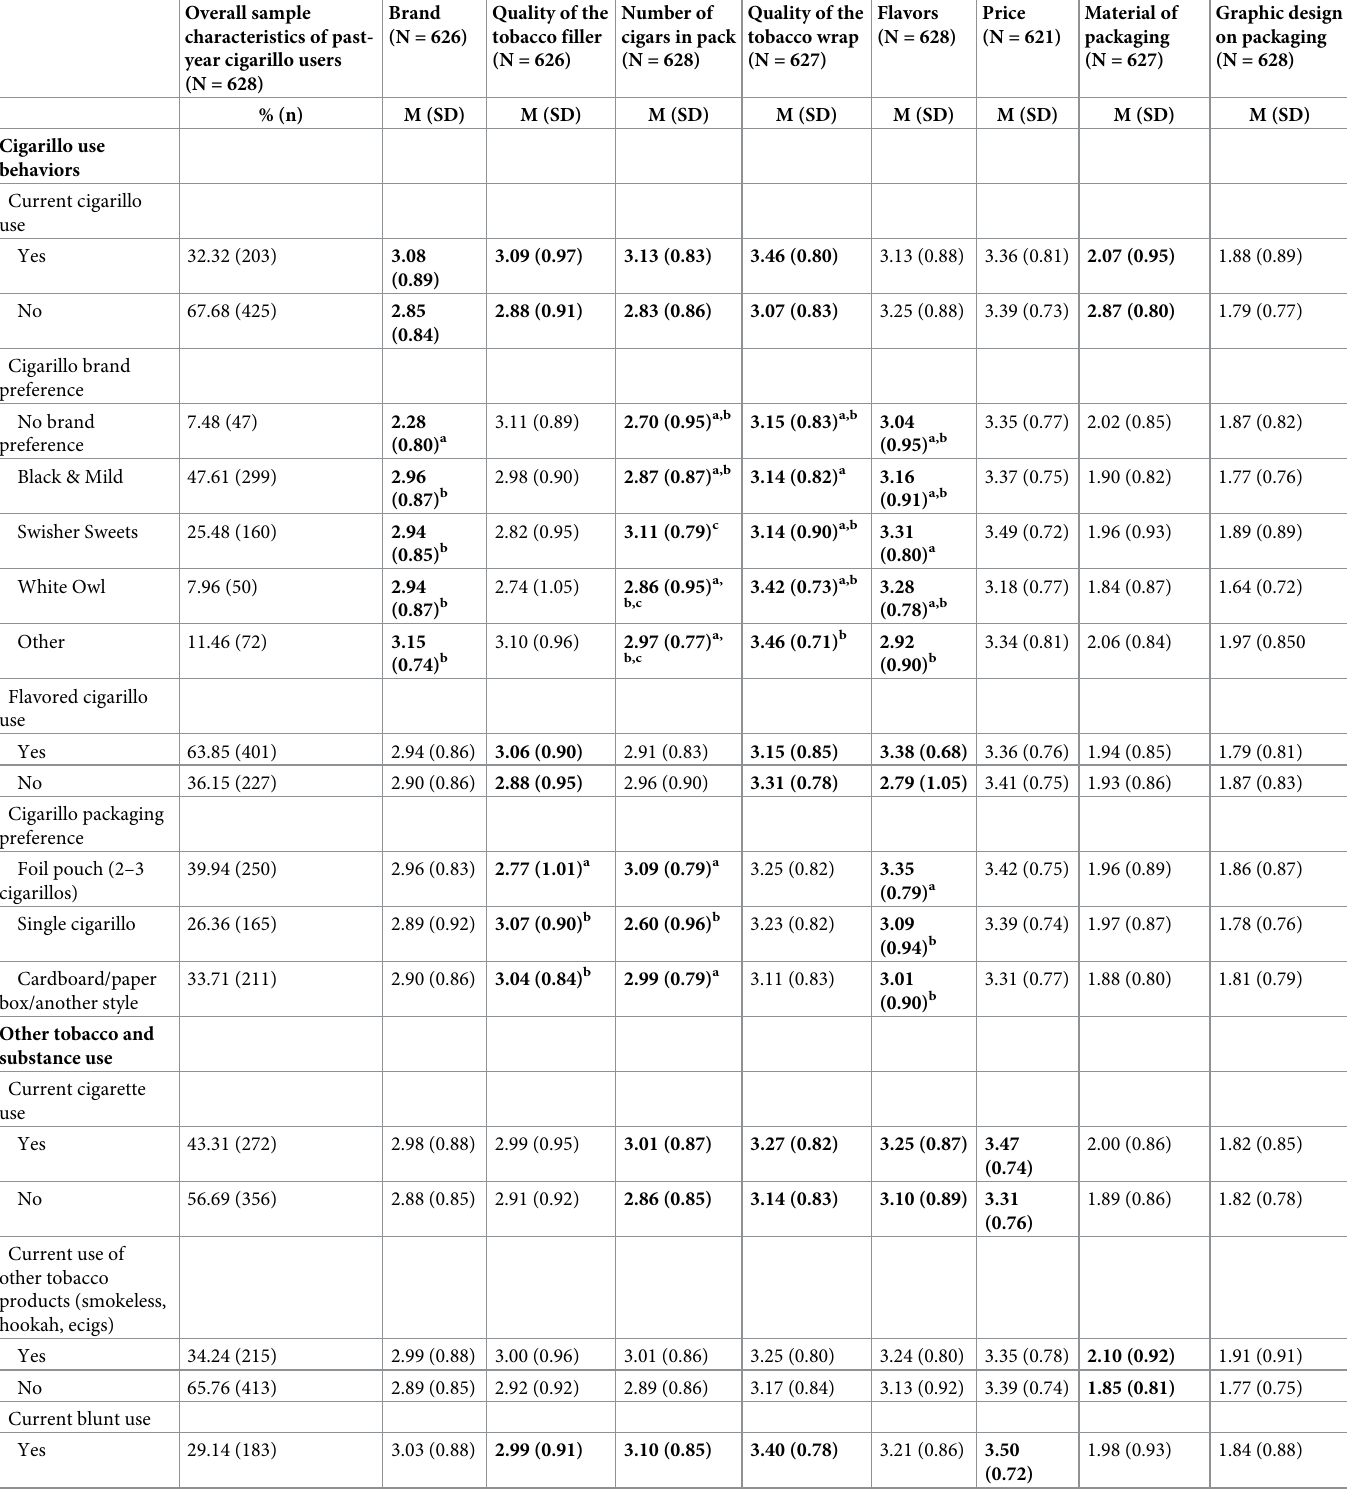
Table 2. Mean importance of cigarillo product characteristics by tobacco and other substance use